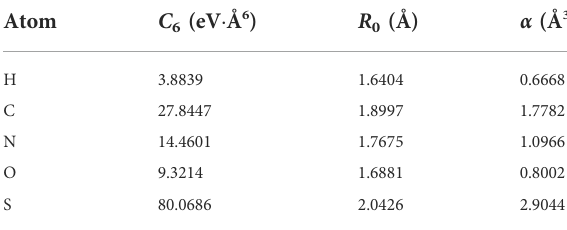
TABLE 1 Parameters employed in the DFT-D TS